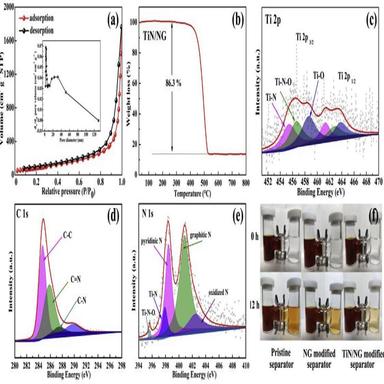
(a) Nitrogen physisorption isotherms of TiN/NG and corresponding pore size distribution (inset). (b) TGA curve of TiN/NG in air with a heating rate of 5 C min1 . High resolution XPS spectra of (c) Ti 2p, (d) C 1s and (e) N 1s in TiN/NG. (f) Li2S6 permeation experiments using H-shape cells with different separators.